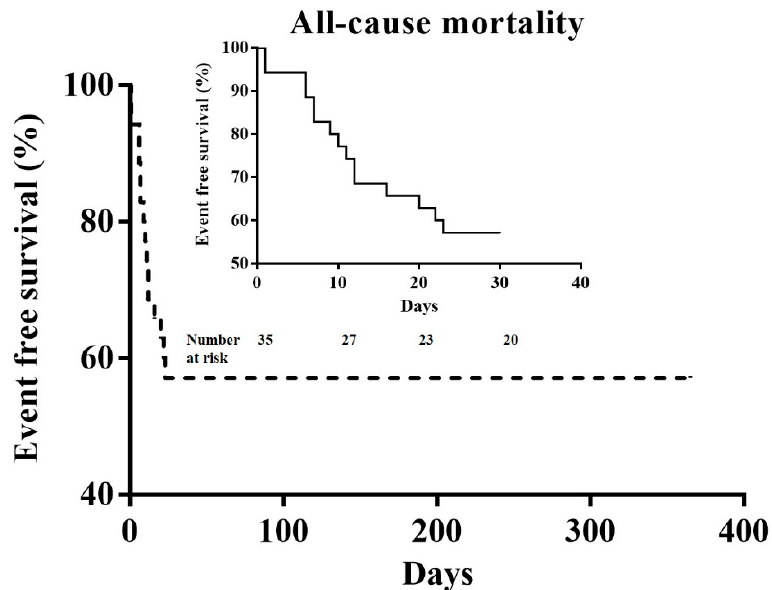
Figure 1. The Kaplan–Meier survival curve over a period of one-year for all-cause mortality. Analysis shows that 57.1% (20/35) of patients survived after the 30-day follow-up period. No patients experienced mortality after discharge during the one-year follow-up period.